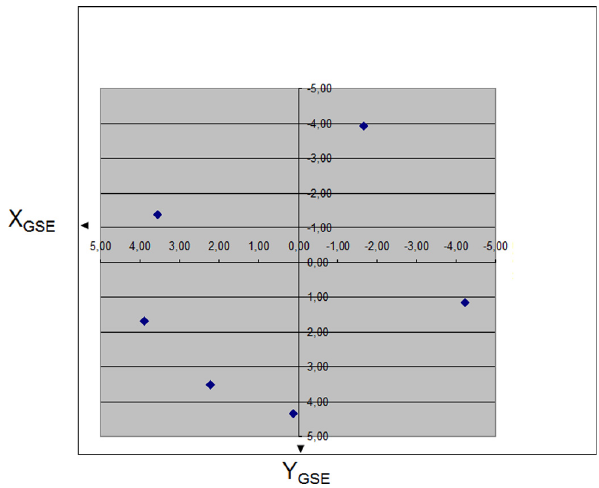
Fig. 9. Distribution in the X GSE - Y GSE plane of the events during which a net outward plasma flow was observed by Cluster inside the outer